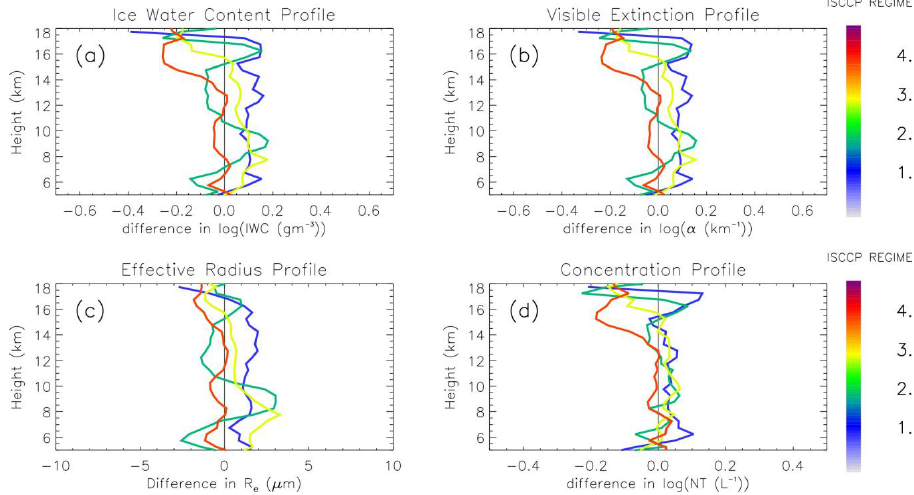
Fig. 15. Same as Fig. 8 but for the ISCCP regimes: CD (blue), STC (green), CC (yellow), and MIX (red).